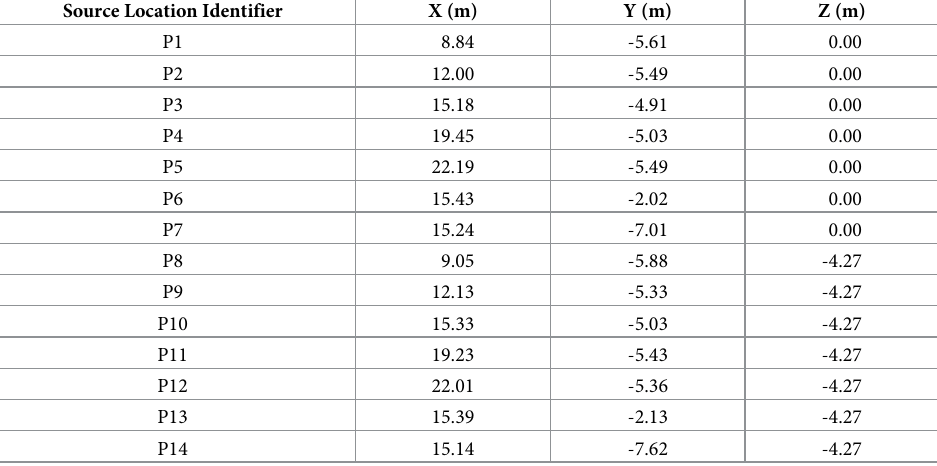
Table 3. Tonal source